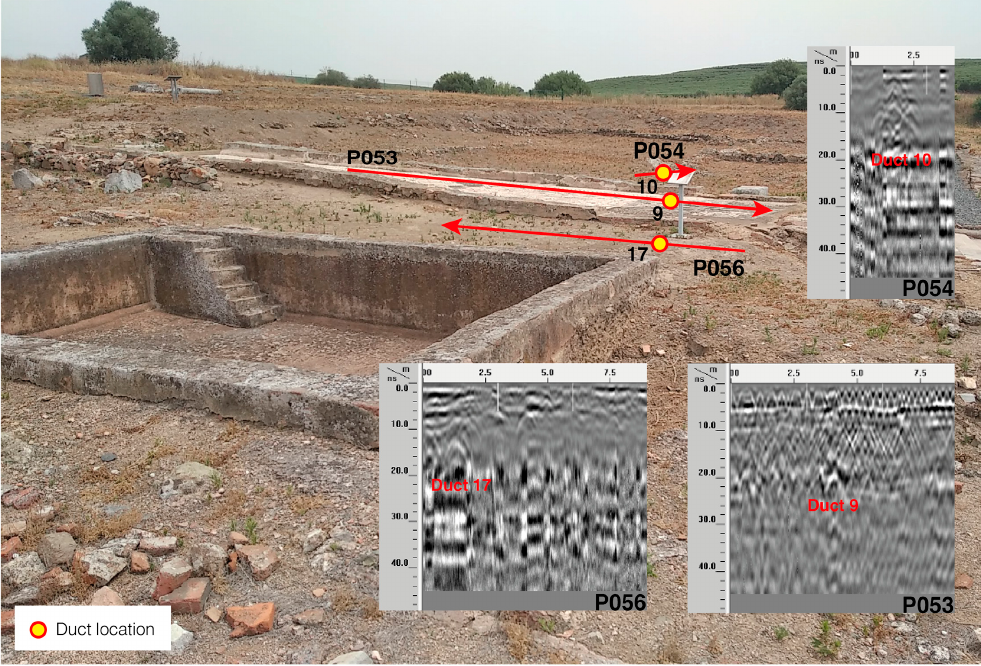
Figure 9. Representation of B-scans P053, P054, and P056 and their location in the field. Figures 10 and 11 show the B-scan reflections in the continuation of drainage con- duits.